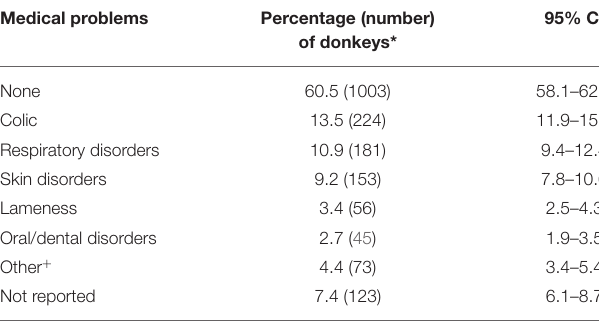
TABLE 9 | Common medical problems of donkeys across smallholder farms in Western Liaoning and Eastern Inner Mongolia of China ( n = 1,658). Medical